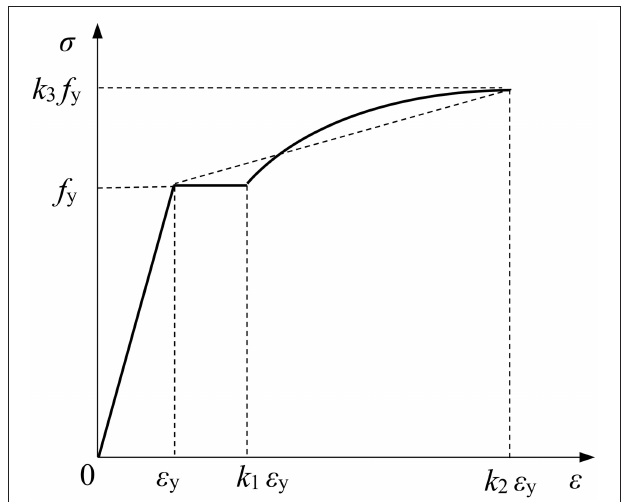
FIGURE 1 | The constitutive model before the degradation of